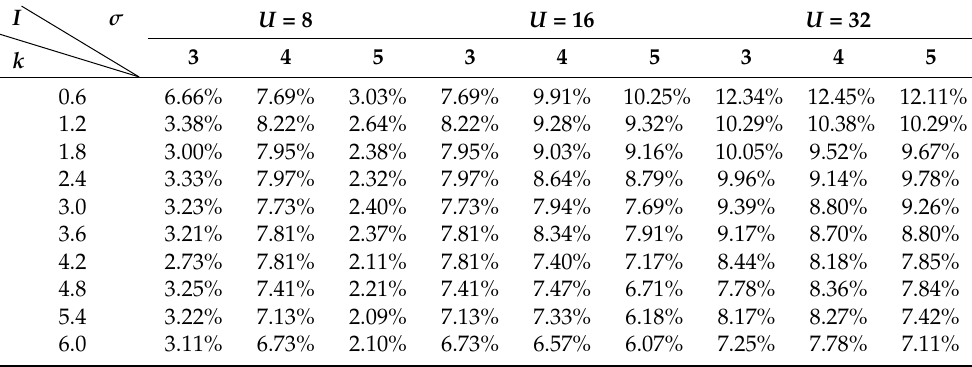
Figure 9. RMSE comparison for OSFRA+ NJW and OSFRA + k- means under various σ , U, and k . ( a ) k = 3, ( b ) k = 4, and ( c ) k = 5. Table 1. Relative improvement of OSFRA+NJW referring to OSFRA+ k -means.